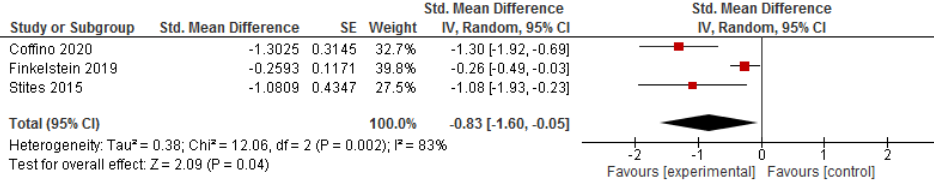
Figure 5. Effect of intervention delivered via online food ordering systems on the Saturated Fat content of purchases.